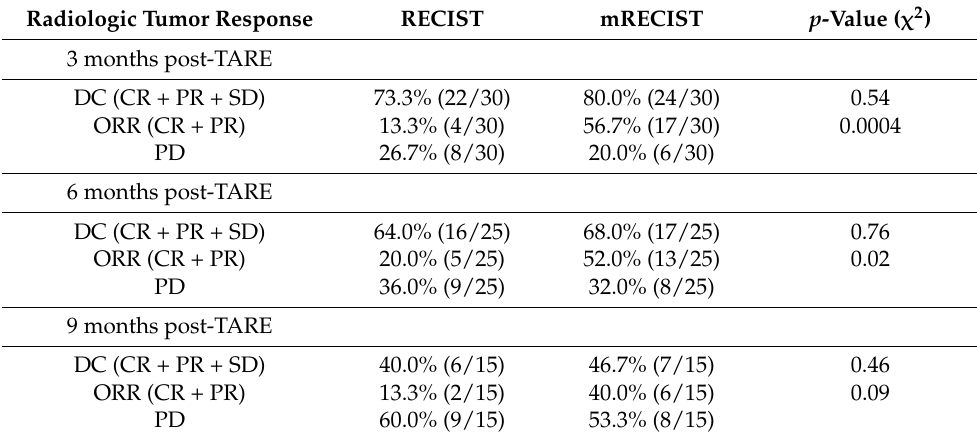
Figure 1. Imaging before and after TARE. ( A ) Preparatory angiography pre-TARE showing several contrast-enhancing lesions in the right hepatic lobe after the administration of iodinated contrast in the common hepatic artery. ( B ) Arterial phase of triphasic liver CT scan showing three arterially enhanced lesions (red arrows) in the right hepatic lobe 2 months before TARE. ( C ) Arterial phase of triphasic CT scan 9 months post-TARE showing significant reductions in both size and the contrast- enhancement of dominant lesions in the right hepatic lobe (red arrow) with the disappearance of minor lesions previously observed in ( B ). Table 2. Tumor response post-TARE.